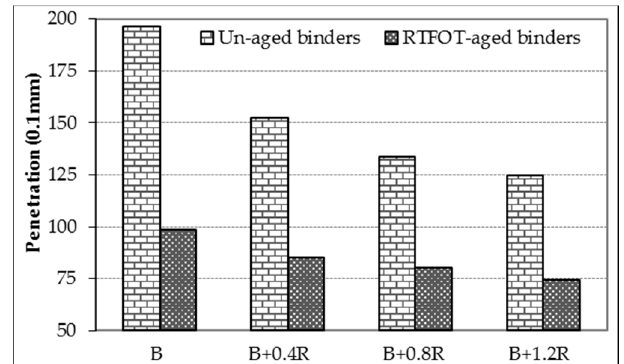
Figure 7. The penetration changing of binders.